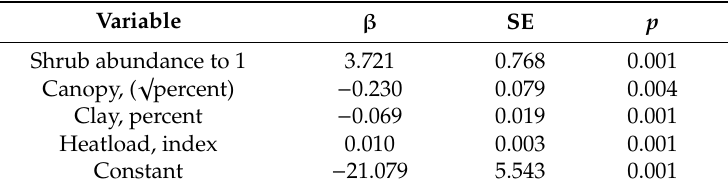
Table 1. Model results predicting blueberry fruit production (scaled from 0 to 1) from 90 plots in northeast Alberta, Canada using fractional logistic regression. Model coe ffi cients ( β ), standard errors (SE), and significance ( p ) are